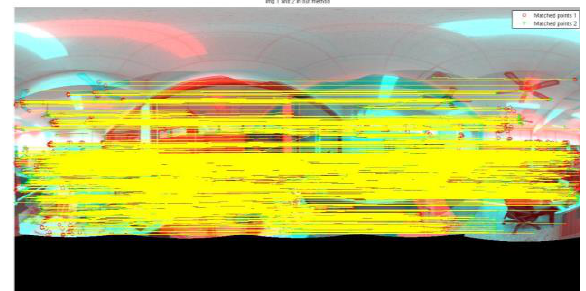
Figure 10(b). Rotation test with Essential matrix model